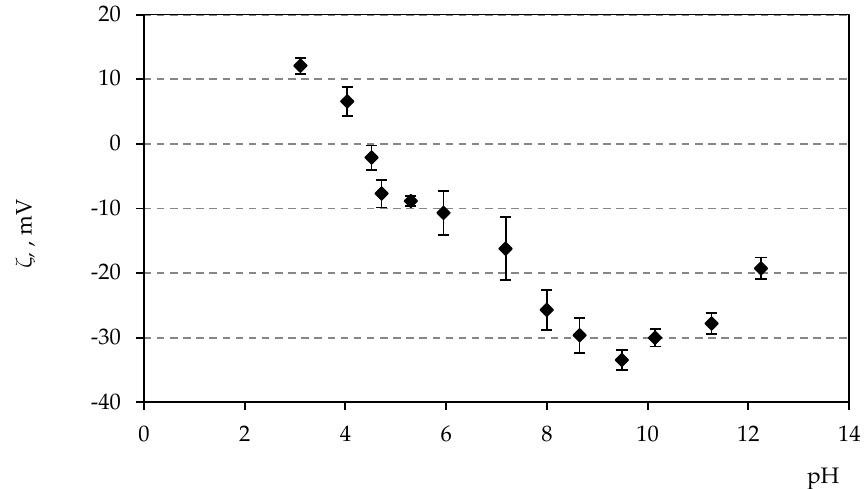
Figure 5. Zeta potential vs. pH values of alumina suspension which contains optimal amounts of additives.